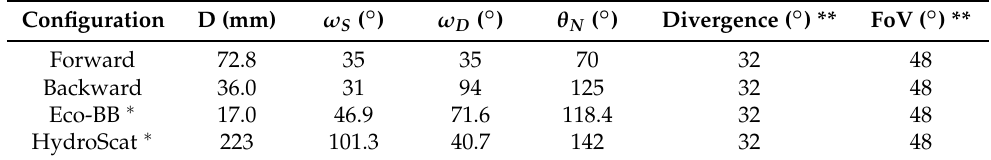
Table A1. Geometrical parameters of different instruments. * [19]. ** The divergence and FoV of the DS was obtained using the full width at half maximum criteria of Equations (A2) and (A3).